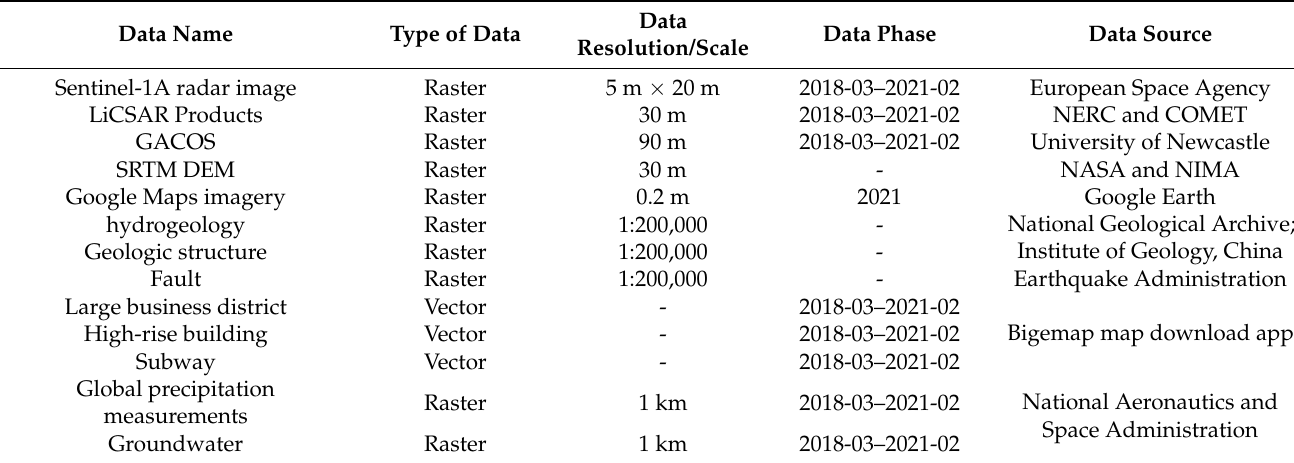
Table 2. Data sources and specifications.